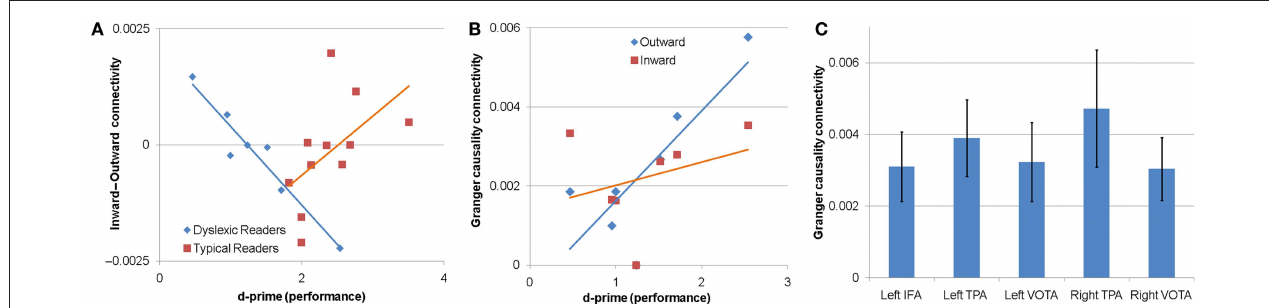
to other areas was associated with better non-word rhyme discrimination performance (d-prime). (B) The relationship between performance and inward and outward connectivity individually for DRs. Greater outward connectivity from the IFA to other areas was associated with better performance in